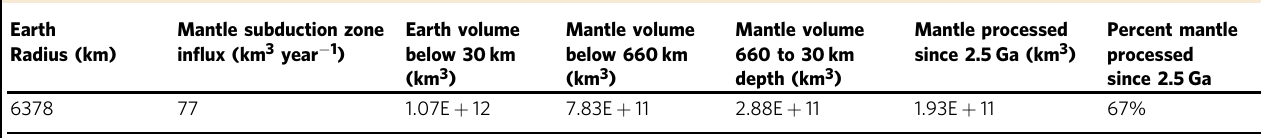
Table 1 Mantle processing